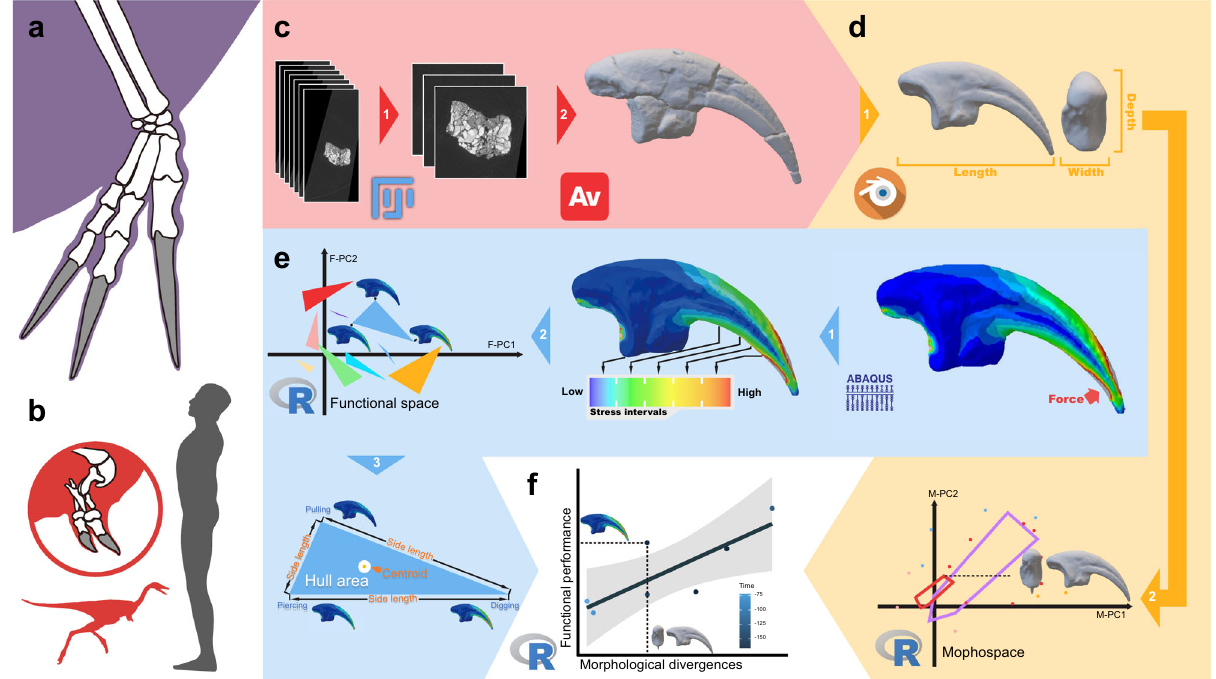
Fig. 1 Key taxa and work pipeline use in this paper. Silhouettes show the large and elongated forelimb of the late-branching therizinosaurian Therizinosaurus ( a ) and the overall body shape and highlighted forelimb of the late-branching alvarezsauroid Mononykus ( b ), scaled against an adult human (height ~1.8 m). The work pipeline demonstrated by an ungual model from the Jurassic alvarezsauroid Haplocheirus , includes processes of 3D model reconstruction ( c ); model smoothing, measurement, and morphological analysis ( d ); fi nite-element analysis, ‘ intervals ’ method and functional-space analysis ( e ); and total evidence functional assessment ( f